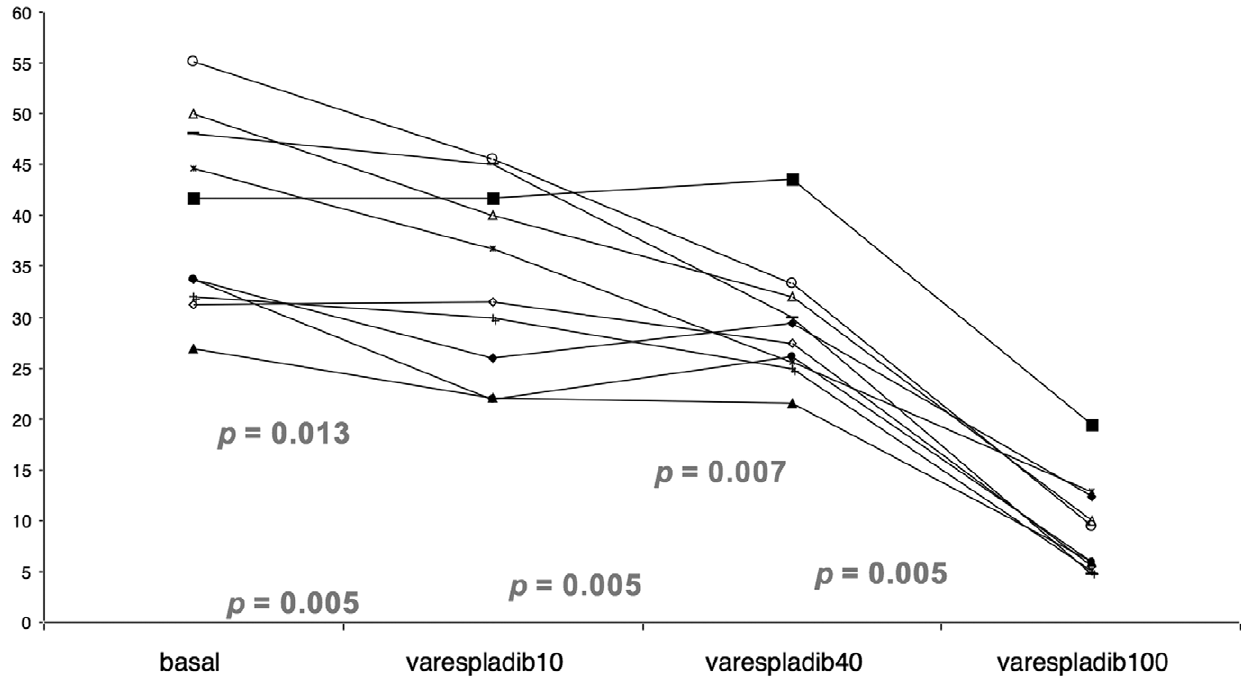
Figure 1. sPLA2 activity in the four BAL aliquots treated either with normal saline (basal), or varespladib at 10, at 40 and at 100 m M. Overall difference in median sPLA2 activity is significant at the Friedman Q -test (see text for details). p -values describe post-hoc comparison: p =0.013 between basal and varespladib10; p =0.007 between basal and varespladib40; p =0.005 between varespladib100 and each other measurement. sPLA2: secretory phospholipase